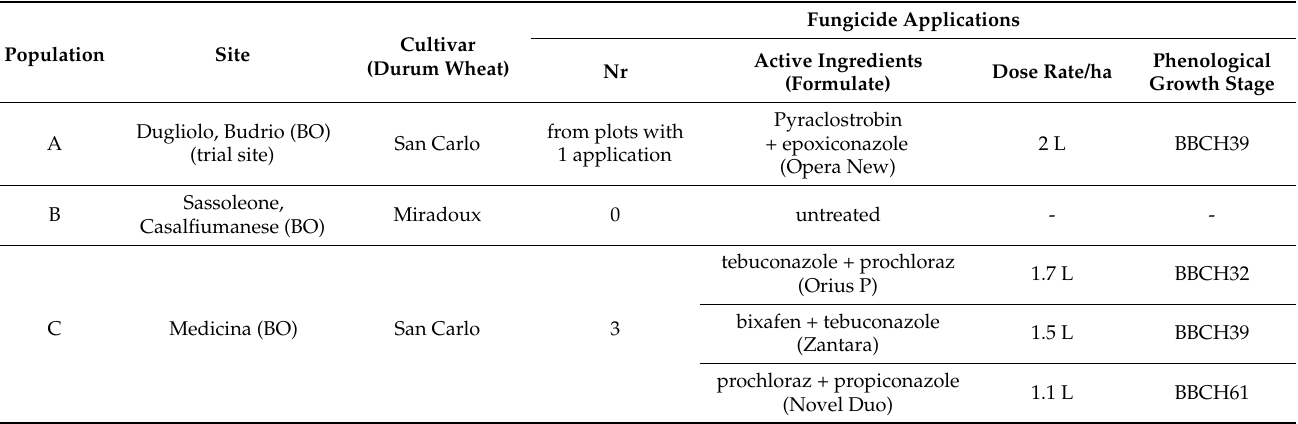
Table 1. Characteristics of Z. tritici populations investigated in this